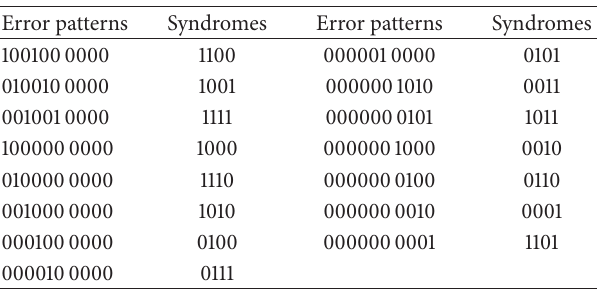
Table 1: Error pattern